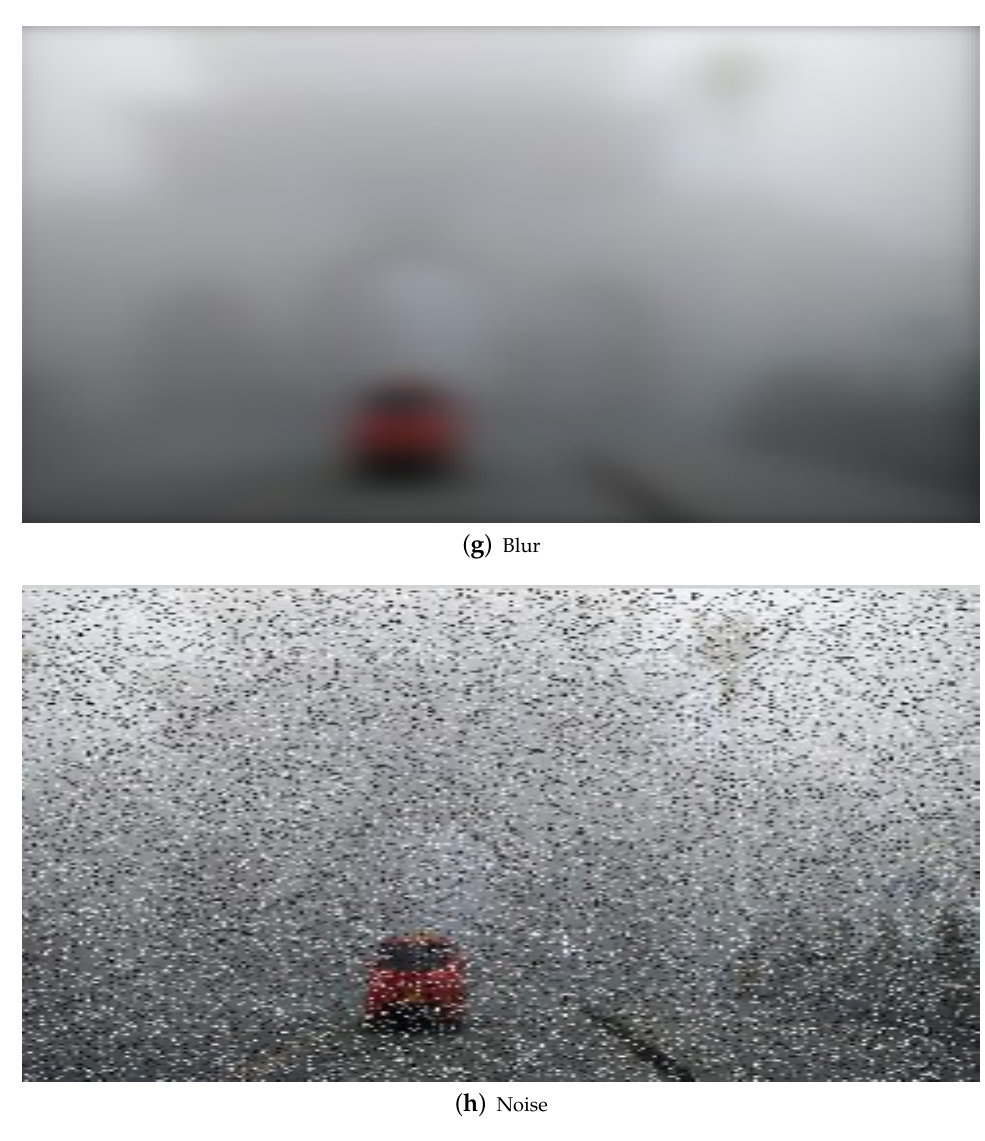
Figure 6. Image augmentation techniques applied.